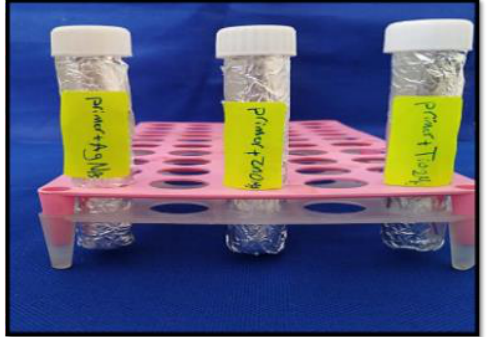
Figure 1: The primer agents after adding the nanoparticles